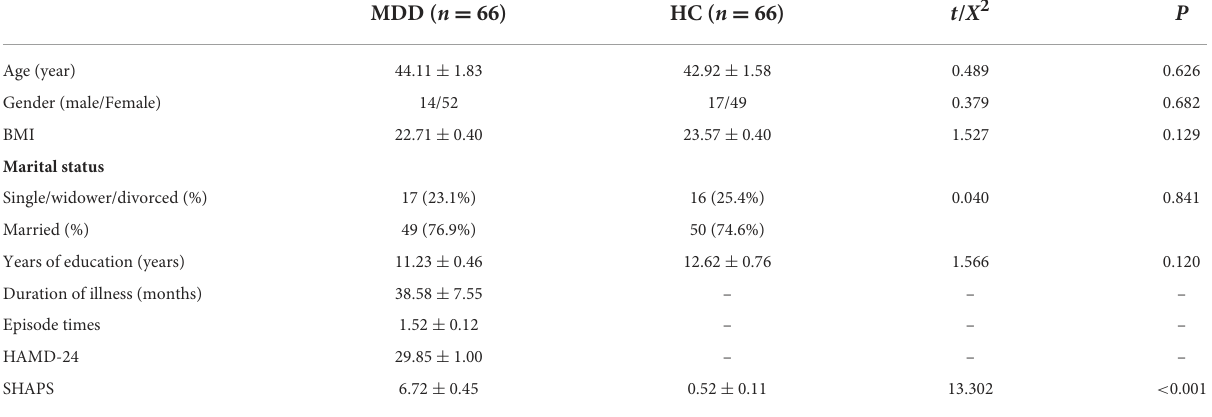
TABLE 1 Demographic and clinical data of participants in MDD and HC.